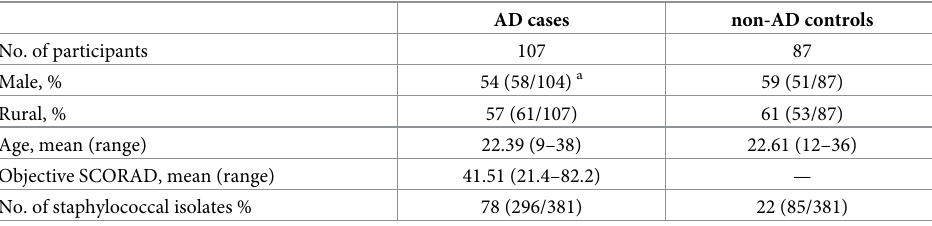
Table 1. Participant